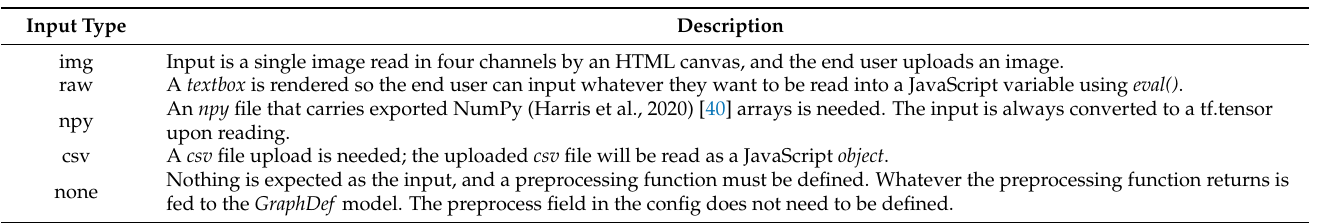
Table A2. Input types and their